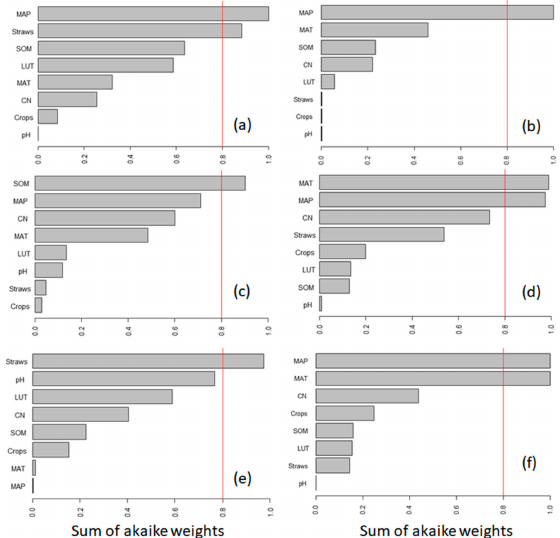
Figure 5. Model-averaged importance of the predictors for the effects of SDMI-amended straw on soil total N ( a ), soil available N ( b ), soil total P ( c ), soil available P ( d ), soil total K ( e ), and soil available K ( f ). SDMI: straw-decomposing microbial inoculant; MAT: mean annual temperature; MAP: mean annual precipitation; LUT: land use type; Straws:straw variety; Crops:crop variety. Cutoff is set at 0.8 (red solid line) to differentiate important from nonessential predictors.